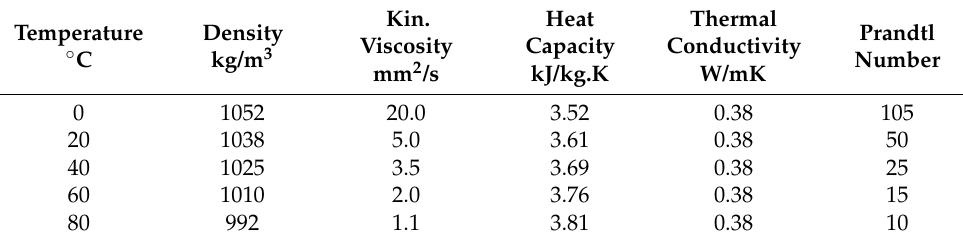
Table 3. Fluid parameters in temperature modes 0 ◦ C to 80 ◦ C